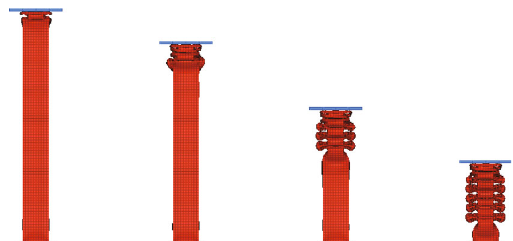
Figure 20: The deformation history of TRB concept tube without transition zone.